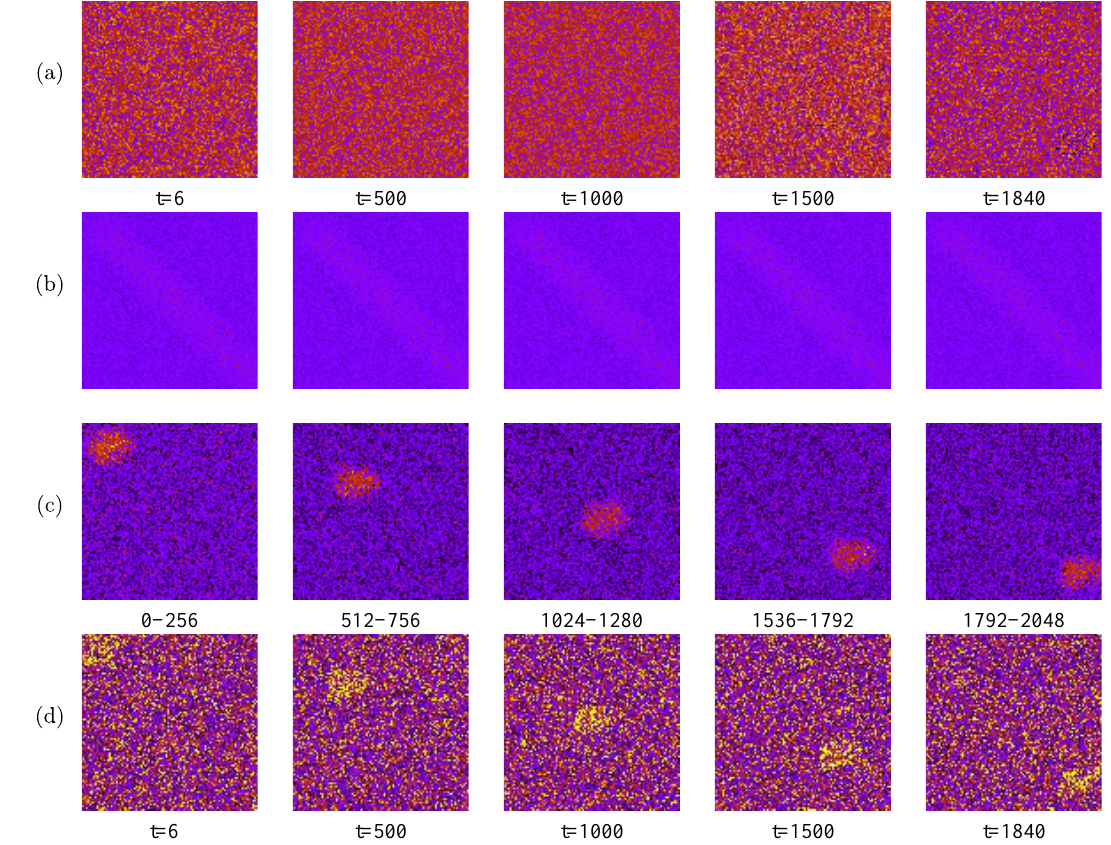
Fig. 3. On detection of a non-stationary (moving) rhythm source. Surrogate data. Row (a) — Surrogate LSI data; Row (b) — averaged Fourier power spectrum at f ¼ 0 : 30468 (the same for the all time moments); (c) and (d) show the selected frames of windowed Fourier power spectrum at the same frequency f ¼ 0 : 30468, and the wavelet power spectrum at f ¼ 0 : 30 for the indicated moments of time, respectively. N A ¼